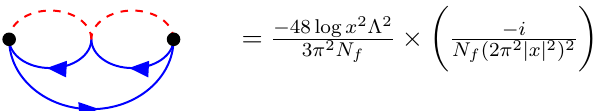
Figure 5 . ( N = 2 SQED) (cid:27) j (cid:8) j 2